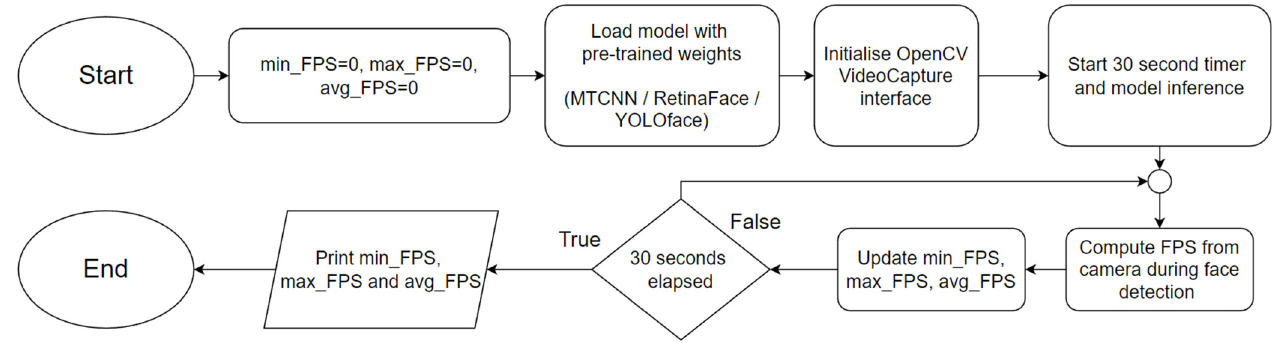
Figure 3. General flowchart for the Python programs used in Experiment 3.